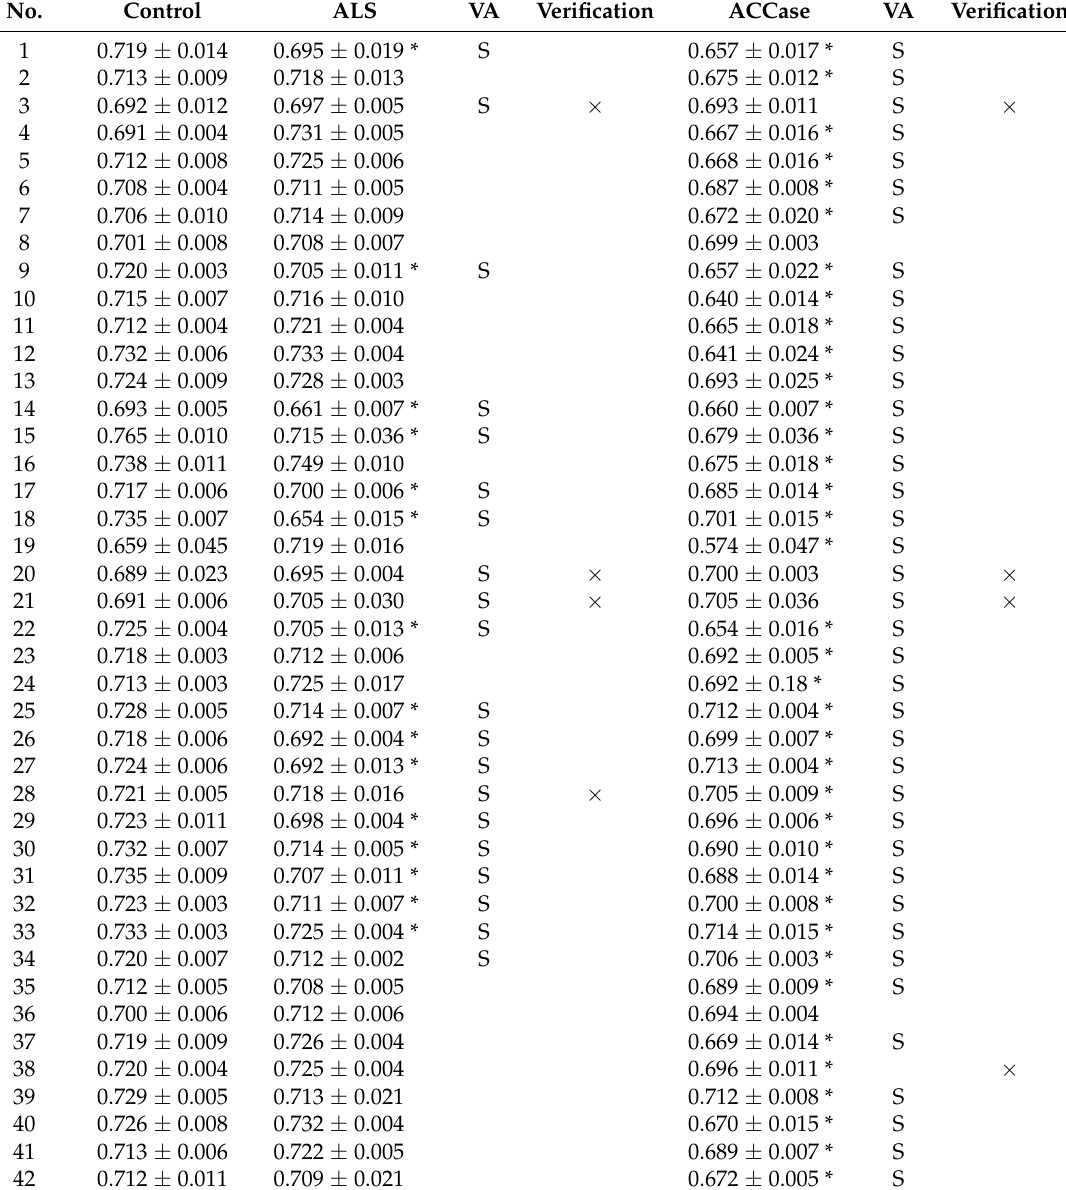
Table 3. Average values of F v / F m of Apera spica-venti in the greenhouse and the Tukey’s HSD test results of treated and untreated plants. ALS: treatment with pyroxsulam plus florasulam; ACCase: treatment with pinoxaden; VA: visual assessment result; S: herbicide sensitive population; *: significant lower F v / F m value of the herbicide treated group than the untreated control group; × , sensor and visual assessment results do not